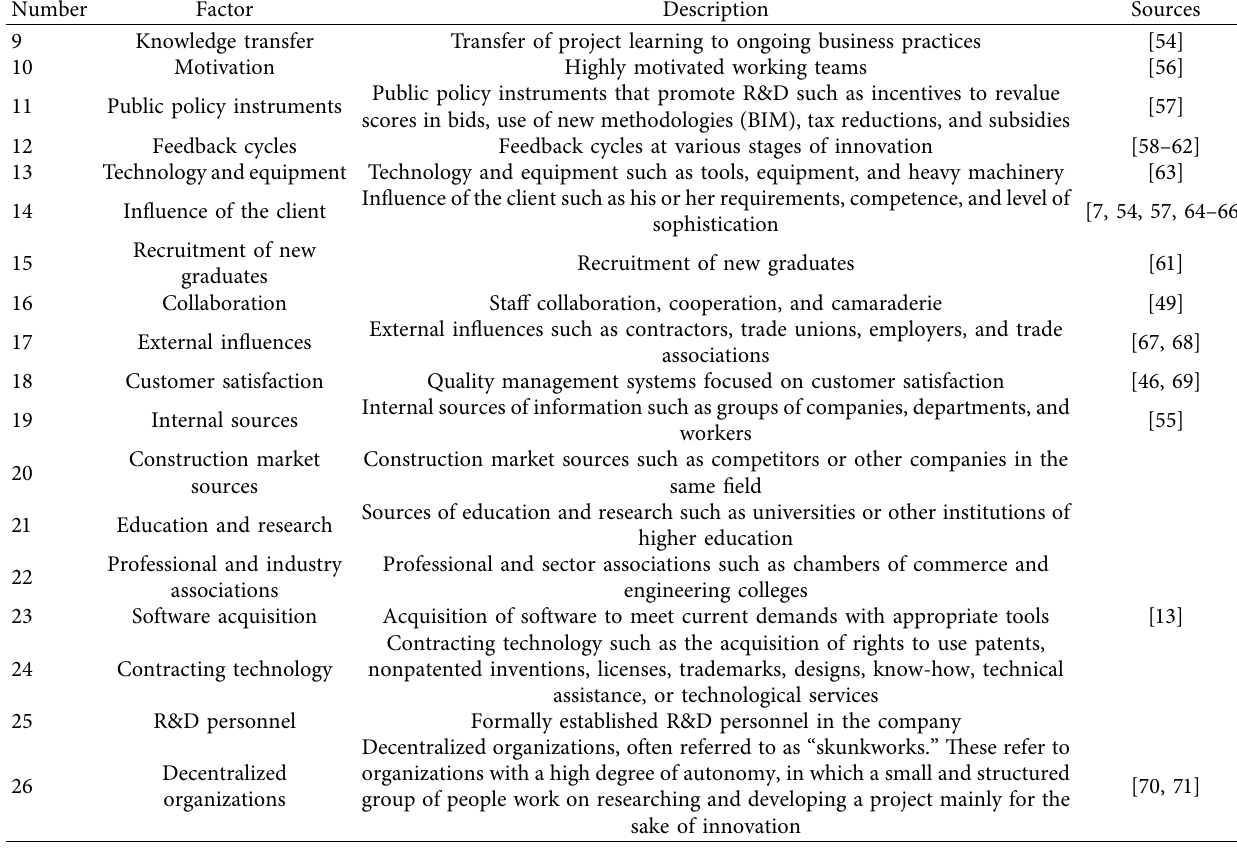
Table 1: Factors at the individual, group, and organizational